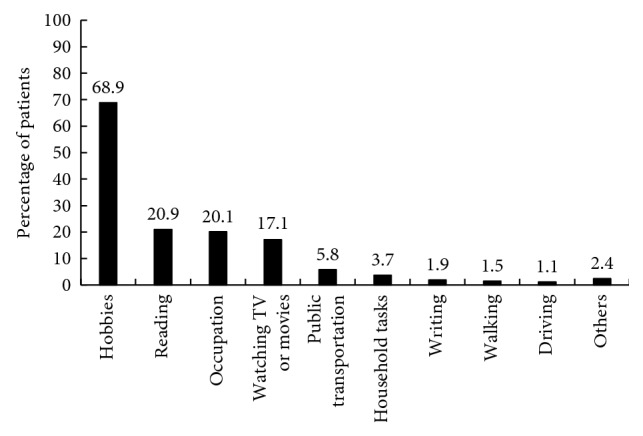
Frequency of needs for visual improvement. Multiple choices were permitted, and therefore, the total category may exceed 100%.